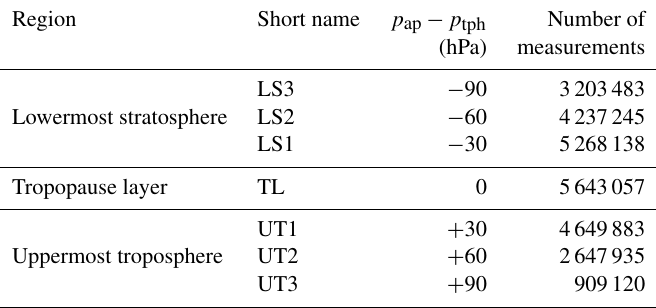
Table 1. The data set is distributed into three main layers: the upper troposphere, tropopause layer and lowermost stratosphere. The outer layers are additionally subdivided into three sublayers. The distribution criterion is the pressure difference between aircraft pressure p ac and the tropopause pressure p tph with the range of ± 15hPa. Additionally, for every flight layer, the number of IAGOS measurements between 2000 and 2009 is presented.